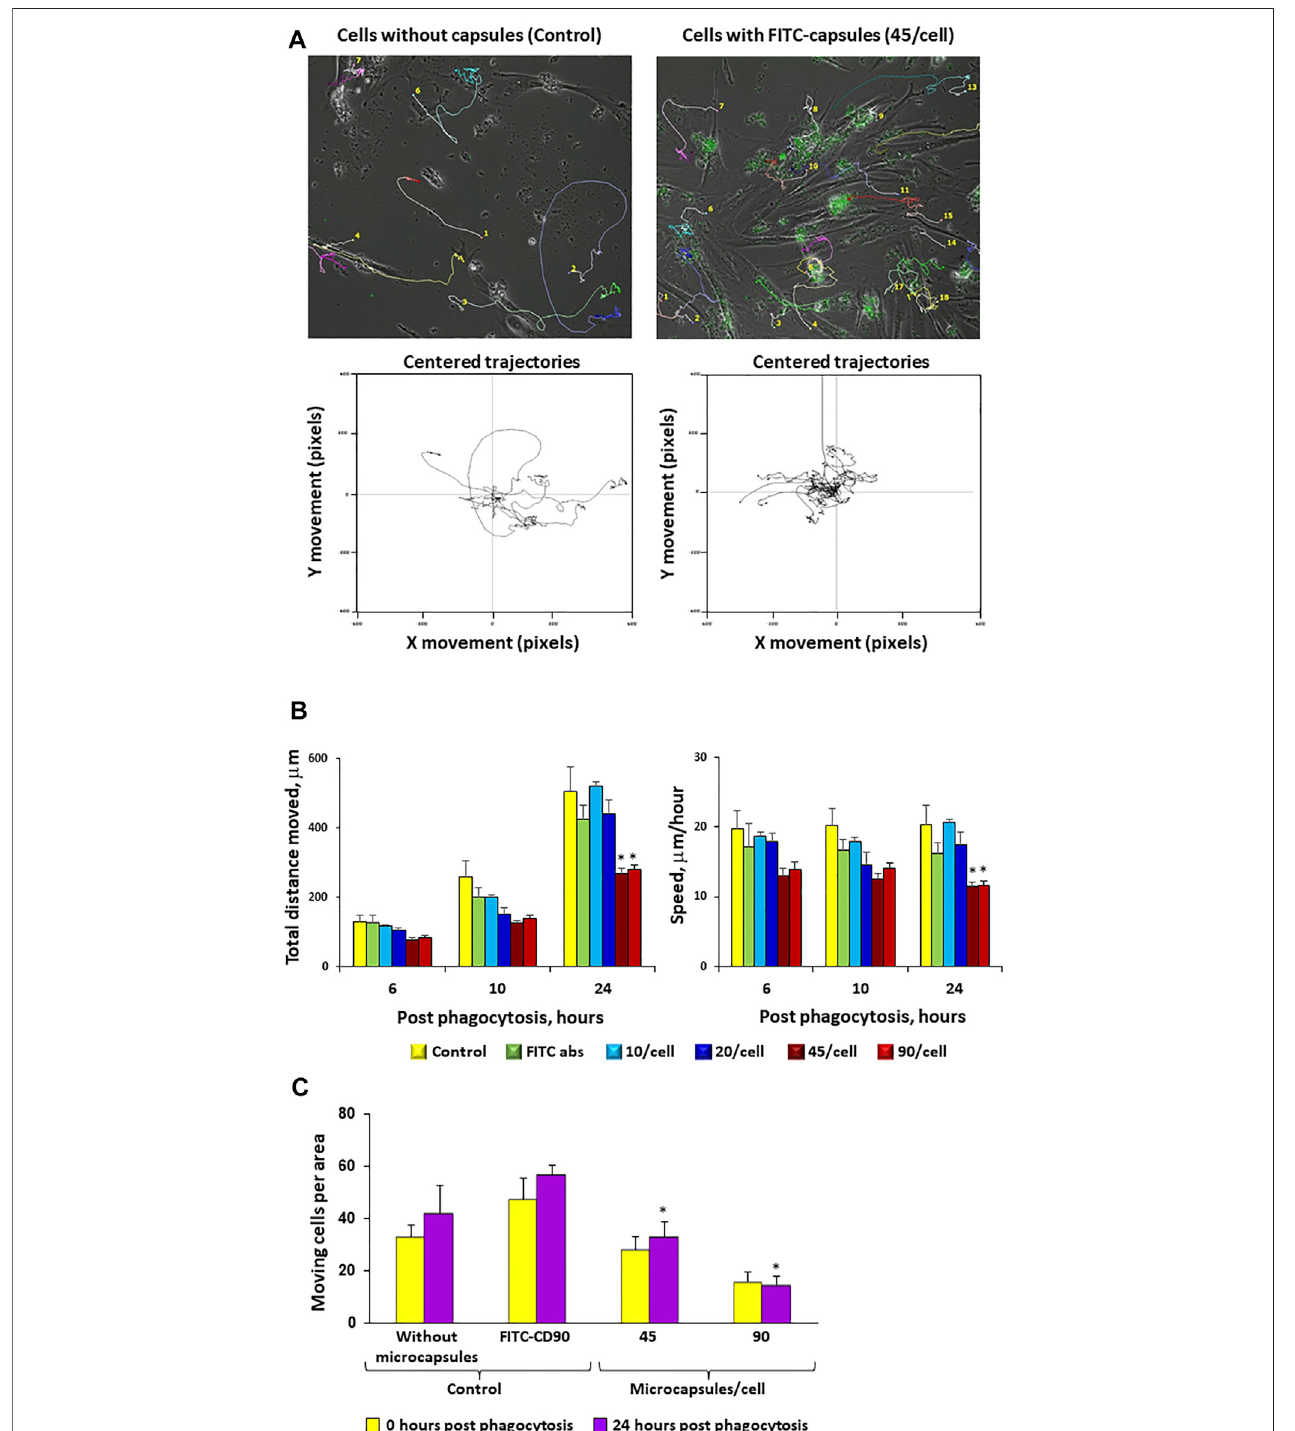
FIGURE 6 | Increasesinmicrocapsuleloadingsigni fi cantlyreducecellularmotility.Post-phagocytosisofmicrocapsulesatratiosof1:0(controlwithoutcapsules),1:10,1:20,1:45, and1:90hMSCswereanalyzedforcellmotilityfor24 hpost-phagocytosisusingtheCell-IQv2MLFintegratedplatformforacontinuousreal-timephase-contrastimagingasdescribedin theMethods.Thecellswereincubatedwithmicrocapsulesfor2 hfollowing fi lmingduring24 hintheCell-IQsystem.Individualcellsweremarkedbycoloredtagsandtracedfor24 hpost- phagocytosis.Time-basedtracesoftheimagesofcellsloadedwith45microcapsules/cellor0/cell(control)over24 hpost-phagocytosis( PanelA ,toppanel).Thelowerpanelshows themovementtracesforindividualcellswitheachtracebeingplacedoverthecenterofthewindow.Cellsloadedwith45microcapsules/cellexhibitedshortertrajectorymovementfrom center( PanelA ,lowerpanel).Fromthesedata,cellmotilitycanbeassessedastotaldistancemovedinanindicatedtimeperiod(6,10,or24 h)orasaveragespeedmovedperhour (Panel B) .The (PanelC) totalnumberofmovingcellsperareaforeachmicrocapsuleratioatindicatedtimepost-phagocytosis.CellsincubatedwithCD90 fl uorescentantibodywereusedasa control. These data demonstrate that increases in microcapsule loading signi fi cantly reduce cellular motility. * r < .05 versus the corresponding control at the same time point.